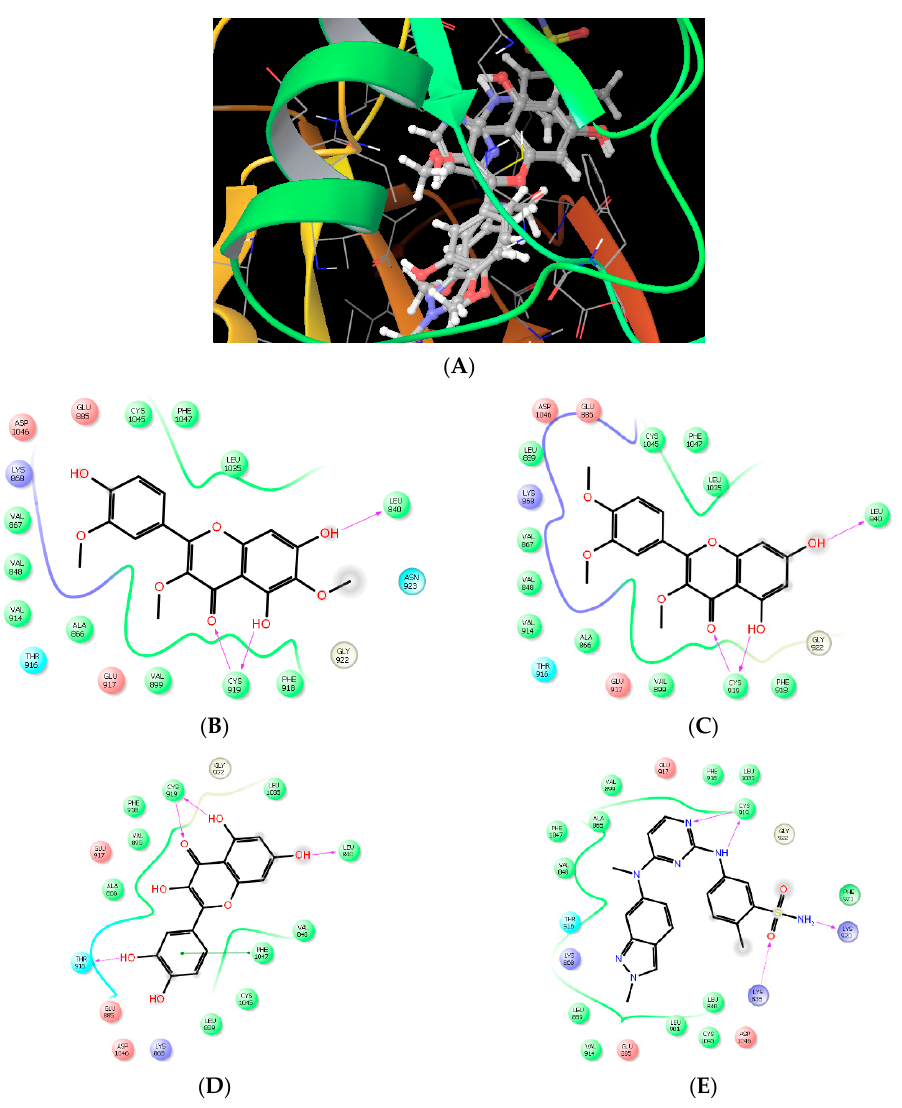
Figure 6. ( A ) 3D-Binding mode of VGEFR-ligand, compound 4, compound 3, quercetin, and genistein in the catalytic domain of 3EWH. 2D-ligand interaction diagram of compound 4 ( B ), compound 3 ( C ), quercetin ( D ), and pazopanib ( E